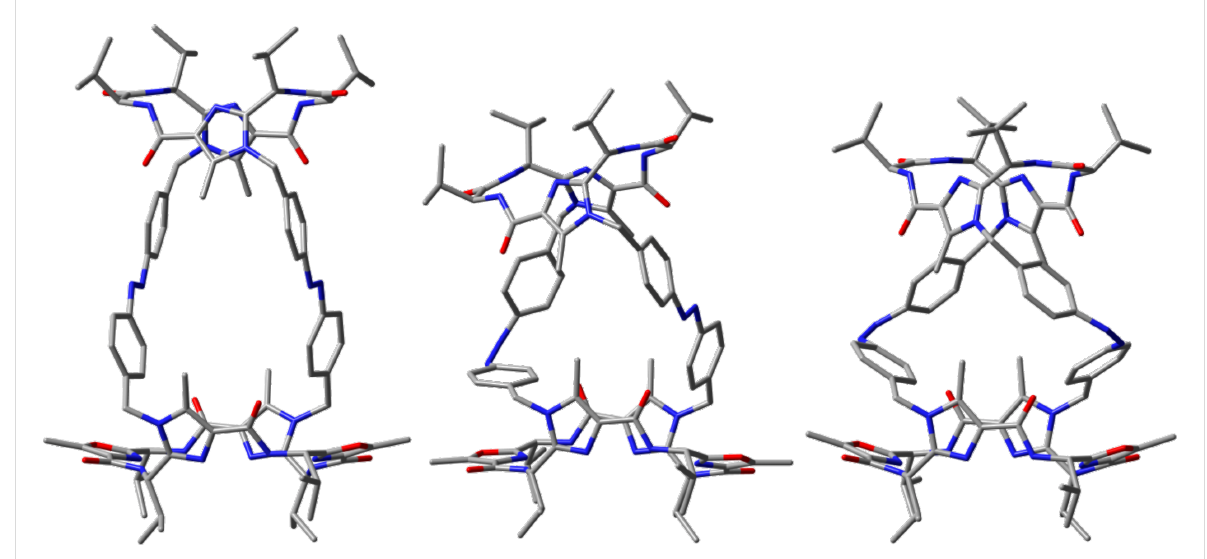
Figure 3: Molecular structures of trans , trans - 10 (left), cis , trans - 10 (middle) and cis , cis - 10 (right) calculated by means of B3LYP/6-31G*. All hydrogen atoms are omitted for the sake of clarity.